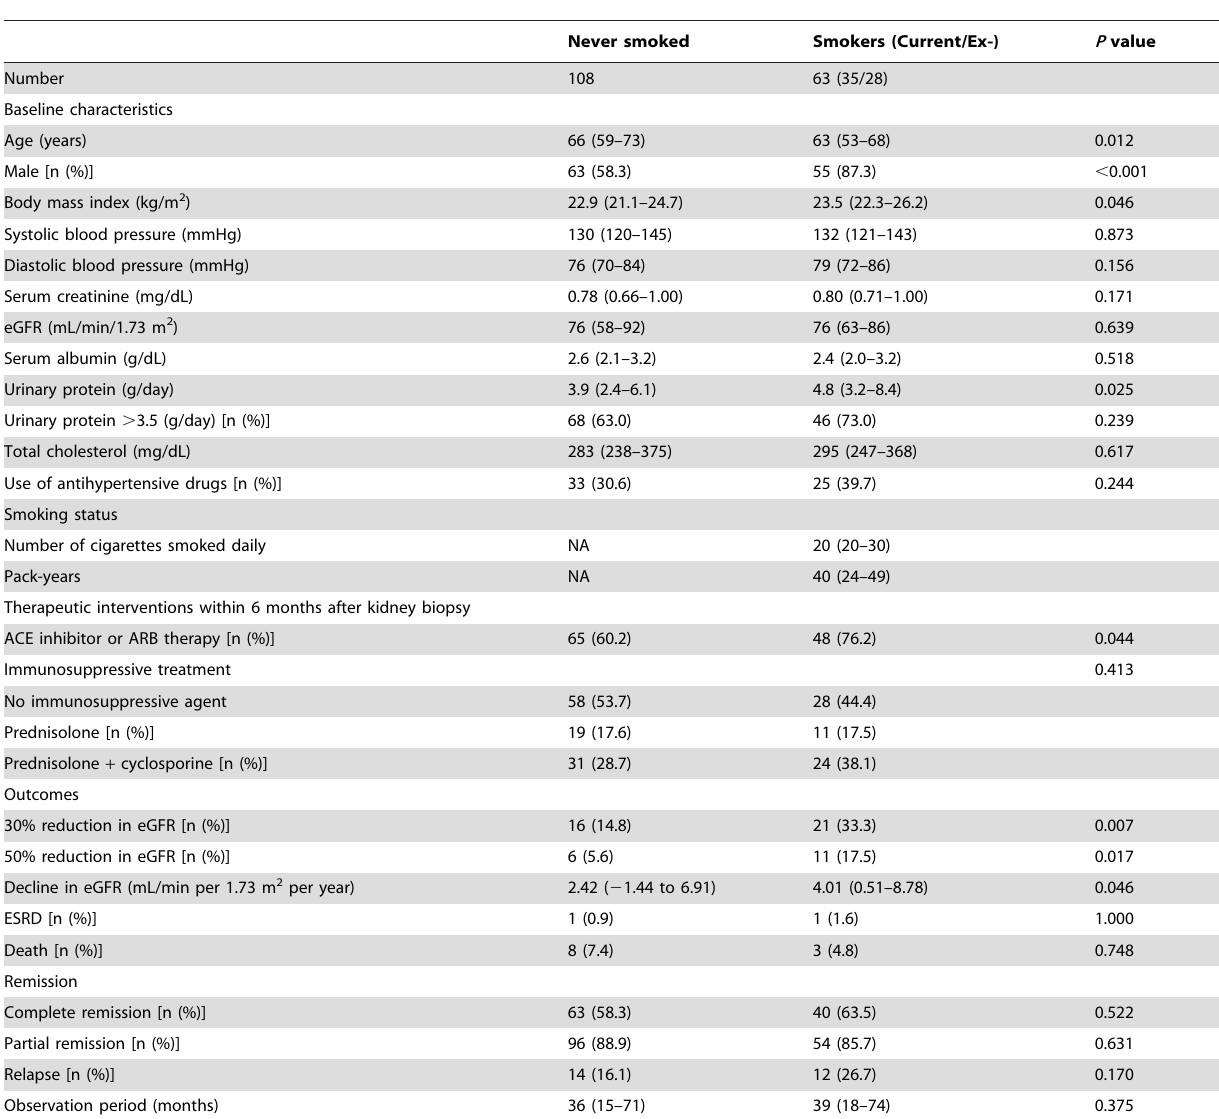
Table 1. Clinical Characteristics of the 171 Patients with